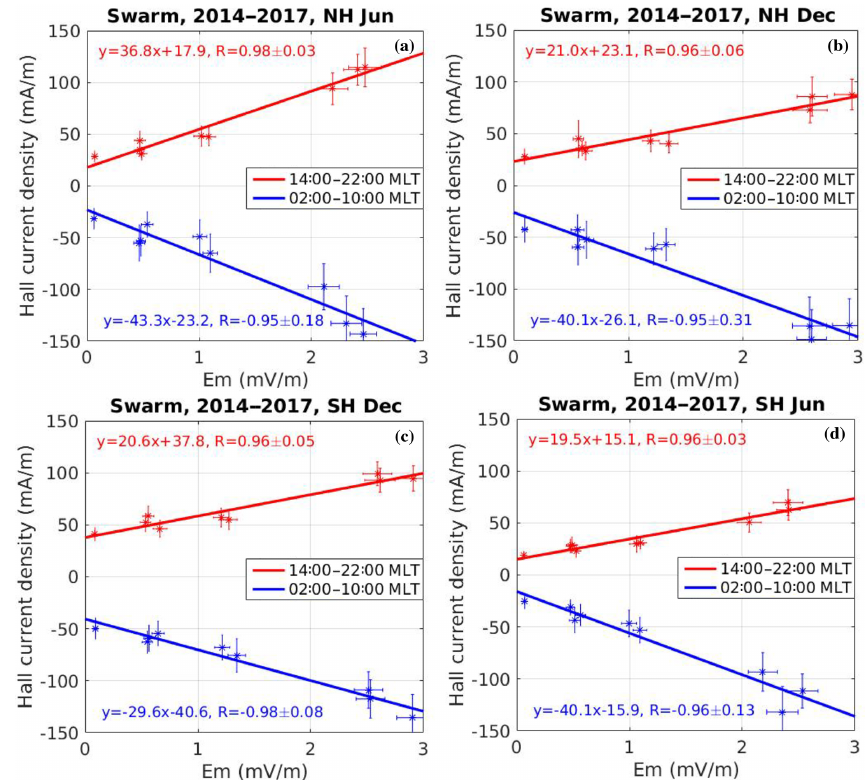
Figure 5. The relationship between mean Hall current density and E m for the dawn and dusk side auroral electrojets. The error bars indicate the uncertainty of mean values both for E m and Hall current density.